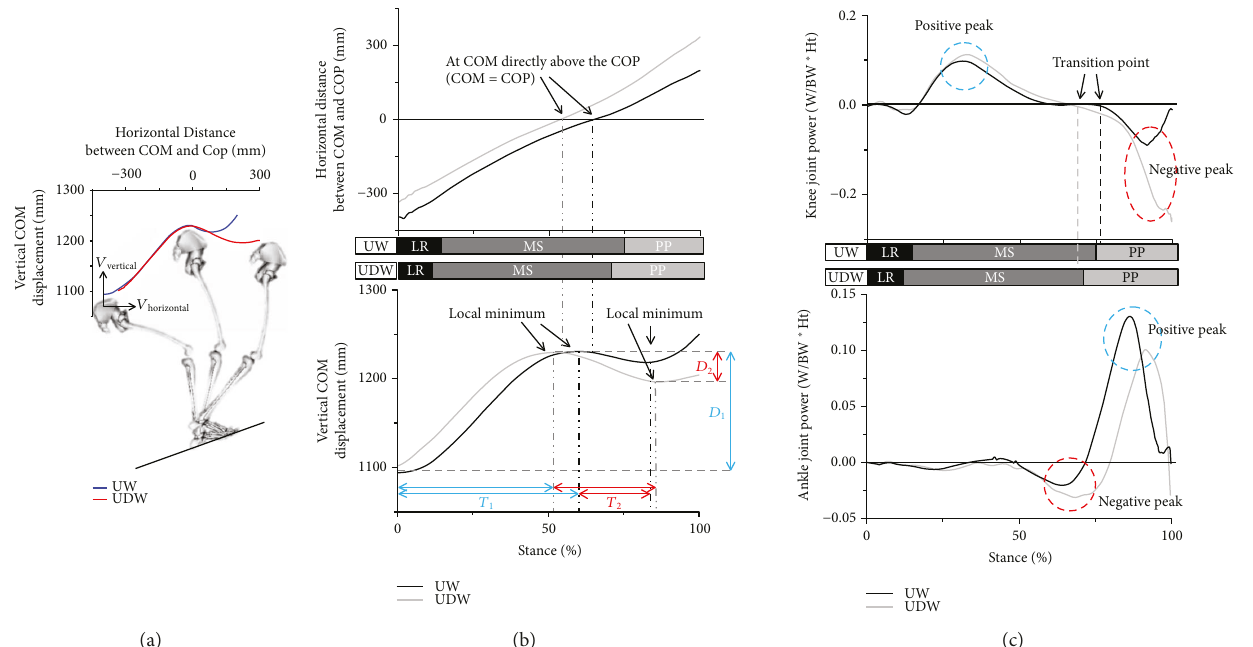
Figure 3: Illustration of the COM and COP movements and Ensemble curves for the joint power. (a) Schematic fi gure of lower-extremity walking on a slope with the mean ensemble curve for the vertical COM displacement versus COM-COP distance during stance. (b) Mean ensemble curves for the vertical COM displacement and the COM-COP distance during stance. T 1 : duration from the initial contact to the local maximum of the vertical COM displacement. T 2 : duration from the local maximum of the vertical COM displacement to the local minimum of the vertical COM displacement. D 1 : displacement of the vertical COM from the initial contact to the local maximum. D 2 : displacement of the vertical COM from the local maximum to the local minimum. (c) Mean ensemble curves for the ankle and knee joint power. The majority of the negative knee joint power and the positive ankle joint power were observed during the propulsion